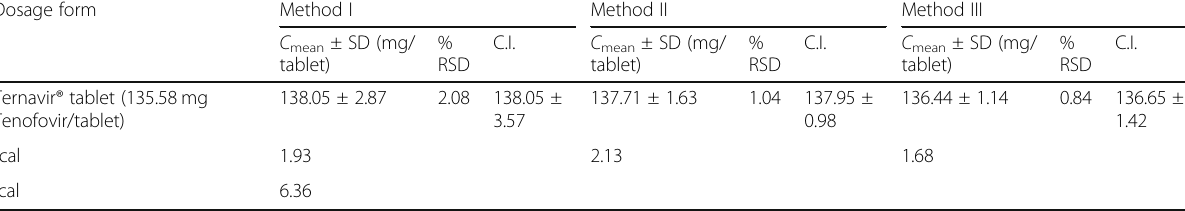
Table 6 Statistical data obtained after application of the proposed methods to the tablet formulation Dosage